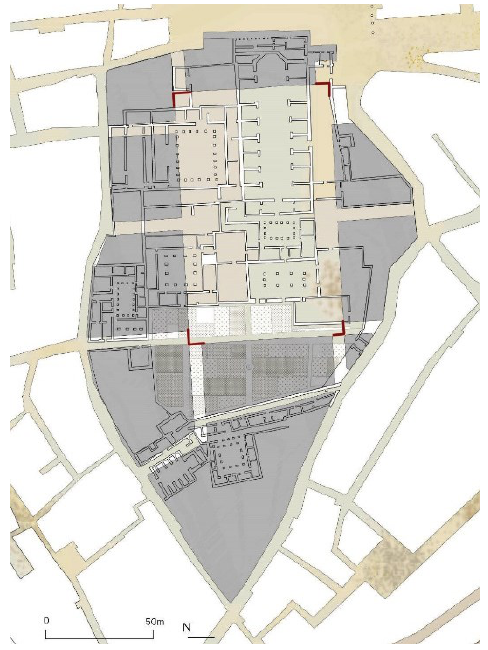
Figure 5. Superposition of the blocks that make up the perimeter of the square and the convent floor: a millimetric correspondence arises between the shape of the complex and the line of rear facades. The future perimeter of the square is framed in red. (The authors, 2019)